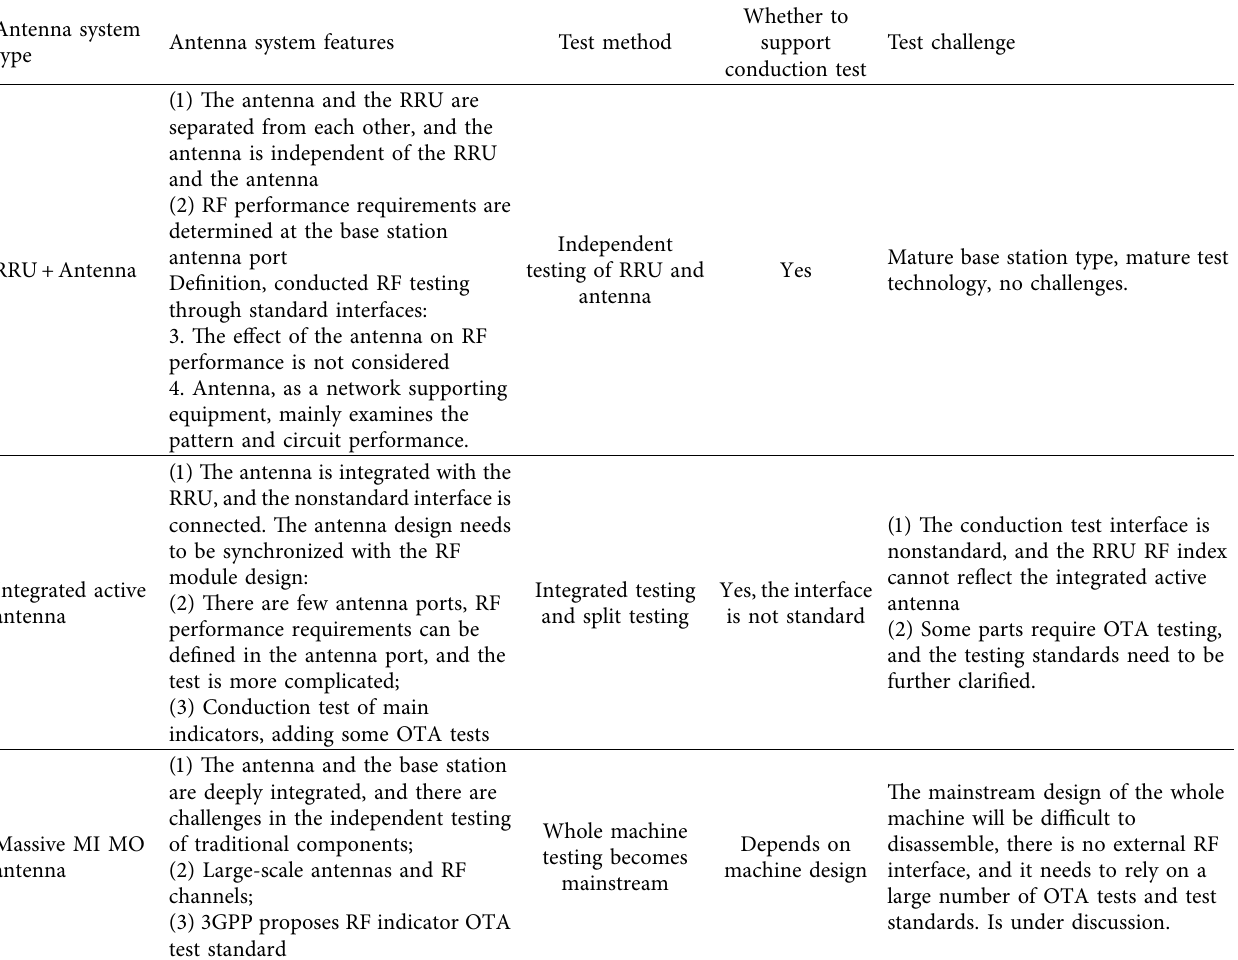
Table 2: Analysis of the characteristics of different types of antenna